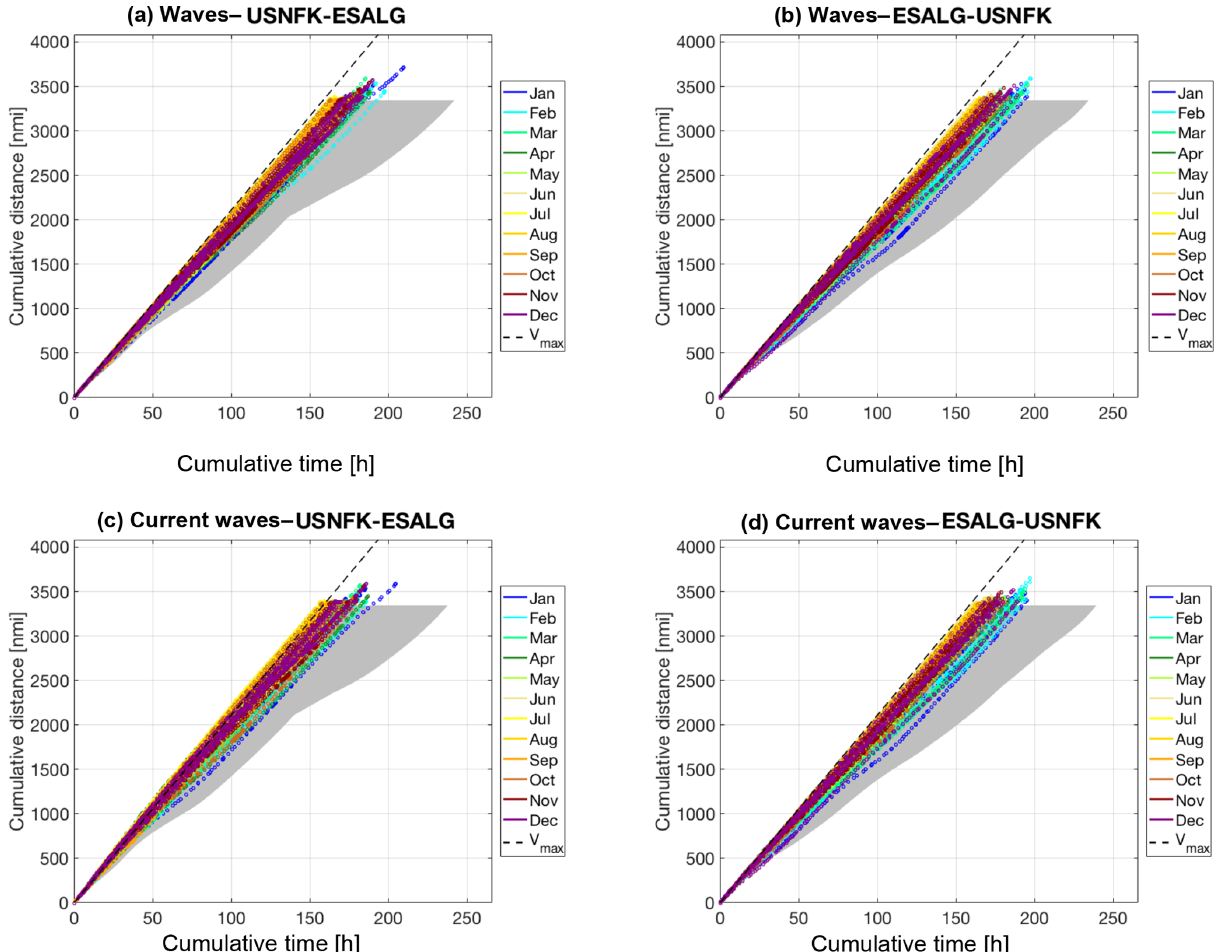
Figure 8. Evolution lines for the tracks in Fig. 7: cumulative sailed distance is displayed vs. time elapsed since departure. Each optimal track is displayed with a coloured dot referring to the month of departure as in the legend. The envelope of the geodetic trajectories is shaded in grey. The dashed line refers to sailing at V max